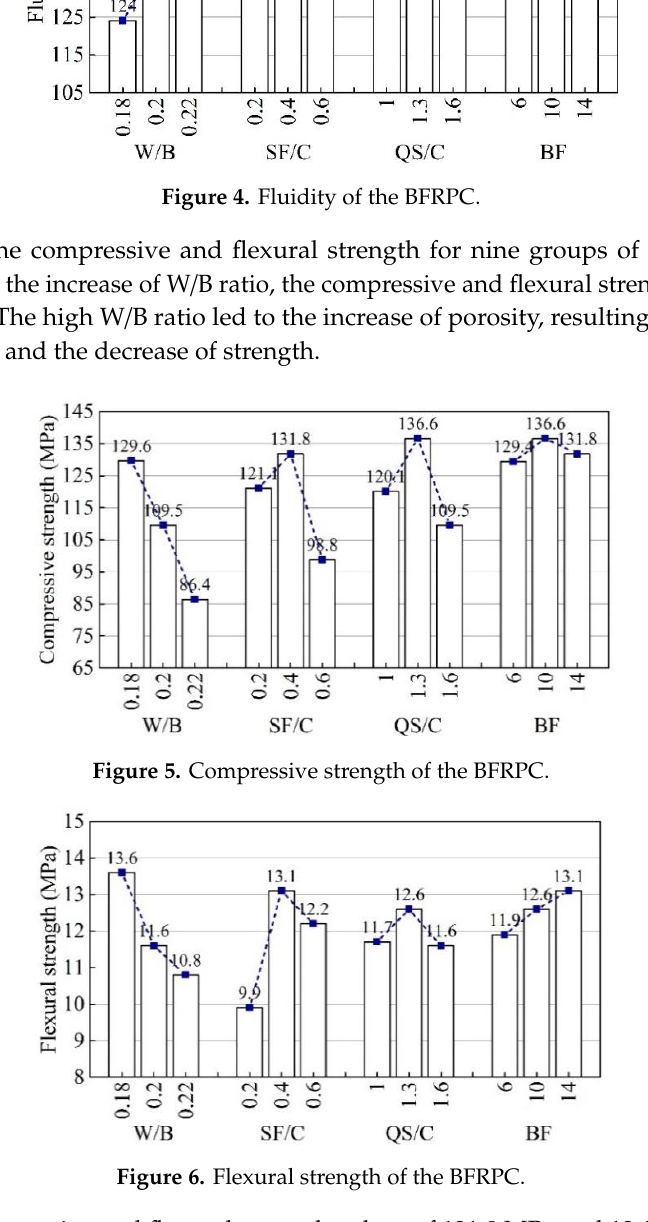
( b ) Figure 7. Failure morphology of BFRPC: ( a ) compressive mode; and ( b ) flexural mode. 4.2. Acoustic Emission Results 4.2.1. Total AE hits It is known that the fracture process of concrete could be confirmed by the analysis of AE characteristic parameters [31]. The AE data for the three groups BF9, BF8, and BF5 were selected for